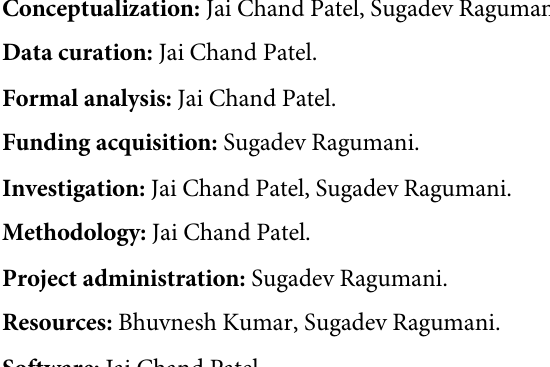
S1 Table. Worldwide monthly RSV raw data for the period Jan 2004 to Dec 2016 with obe- sity as the reference term and shape distance matrix for this period. S2 Table. Worldwide monthly RSV raw data for the period Jan 2004 to Dec 2016 without reference term. S3 Table. Monthly RSV of USA (NH) and NZL (SH) for obesity, hypertension, obesity and fibrosis diseases (Jan 2004 to Dec 2016) with obesity as the reference term. The combined RSV for the Group 1 diseases, the season wise window size of six months period and BMA for Group 1 diseases were displayed for both USA (Red) and NZL (Blue). S4 Table. Worldwide weekly RSV raw data for the period Jan 2004 to Dec 2016 without ref- erence term and shape distance matrix for this period. S5 Table. The complete reference of the labelled PMIDs of the Fig